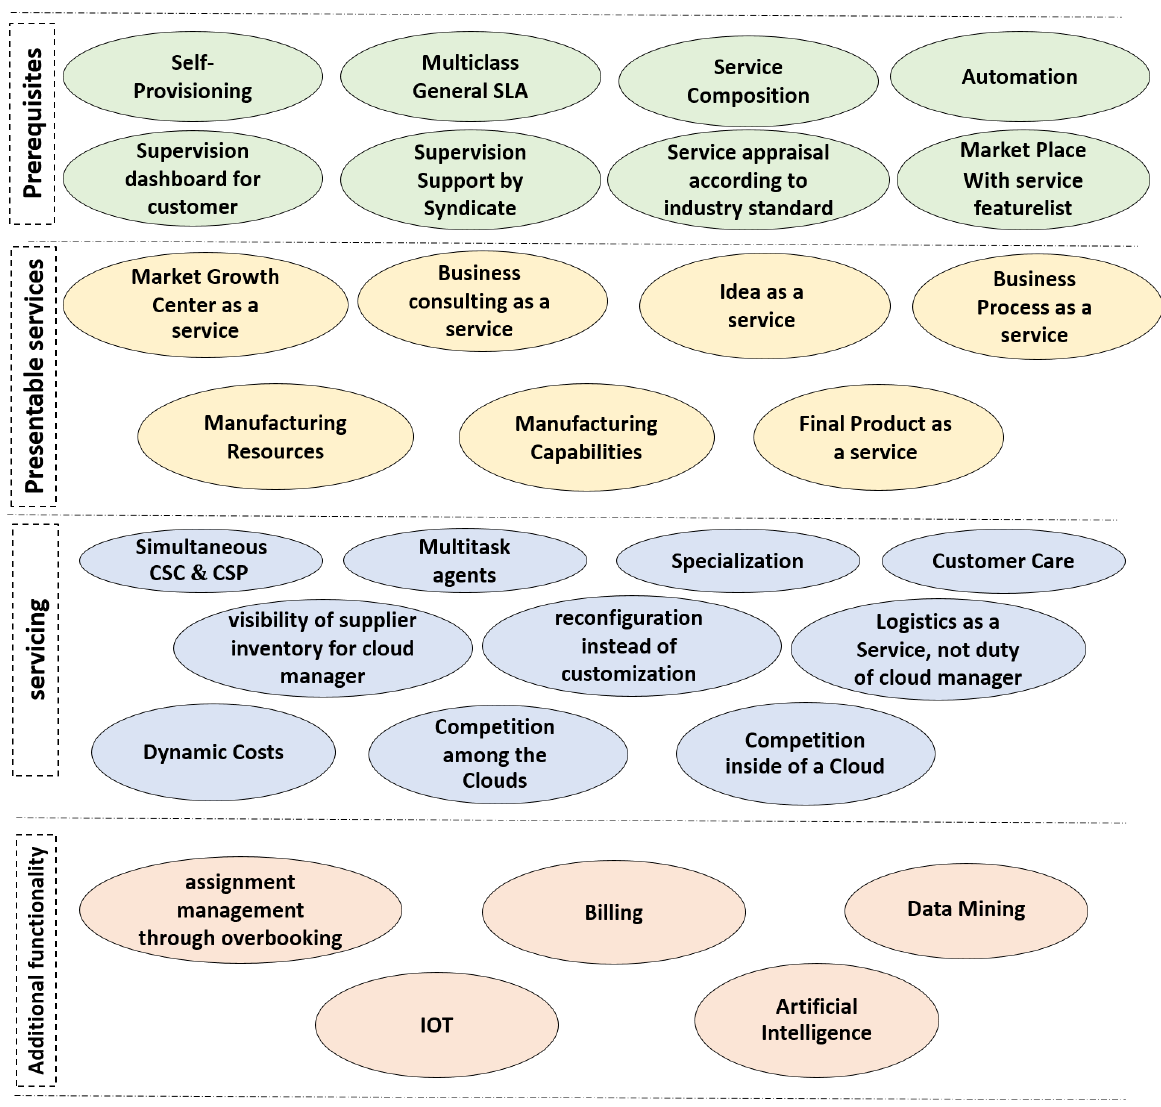
Figure 2. Lean-cloud framework in manufacturing